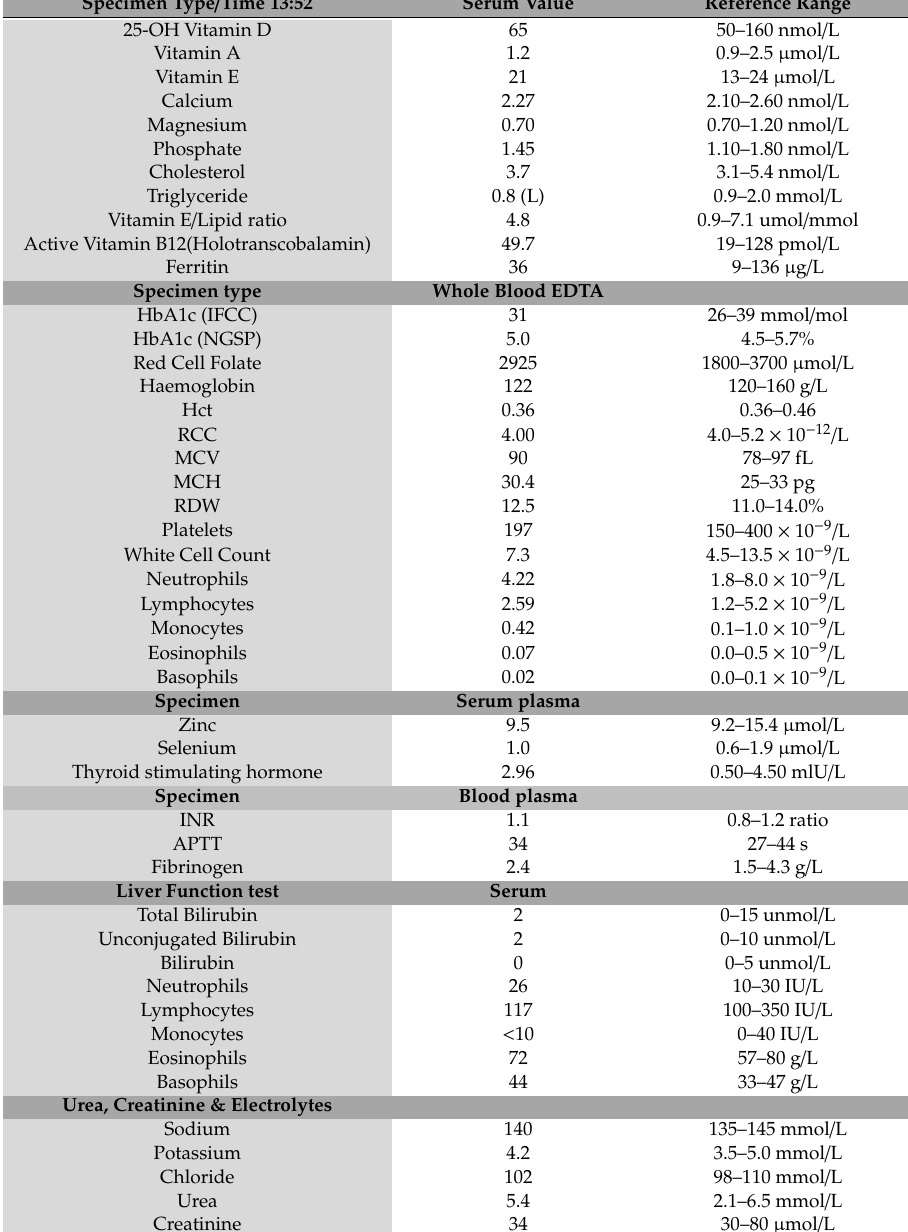
Table 2. Blood serum measures after 12 years of treatment Caralluma fimbriata extract (CFE) intervention. Blood serum measures after 12 years of treatment CFE ingestion, in a single-case of a 14-year-old female with Prader-Willi syndrome (PWS). IFCC - International Federation of Clinical Chemists; NGSP - National Glycohemoglobin Standardization Program; Hct – haematocrit; RCC – red cell count; MCV – mean corpuscular volume; MCH – haemoglobin devided by the number or red cells; RDW – red blood cell width and distribution; EDTA as an anticoagulant, INR—international normalized ratio and APTT—activated partial